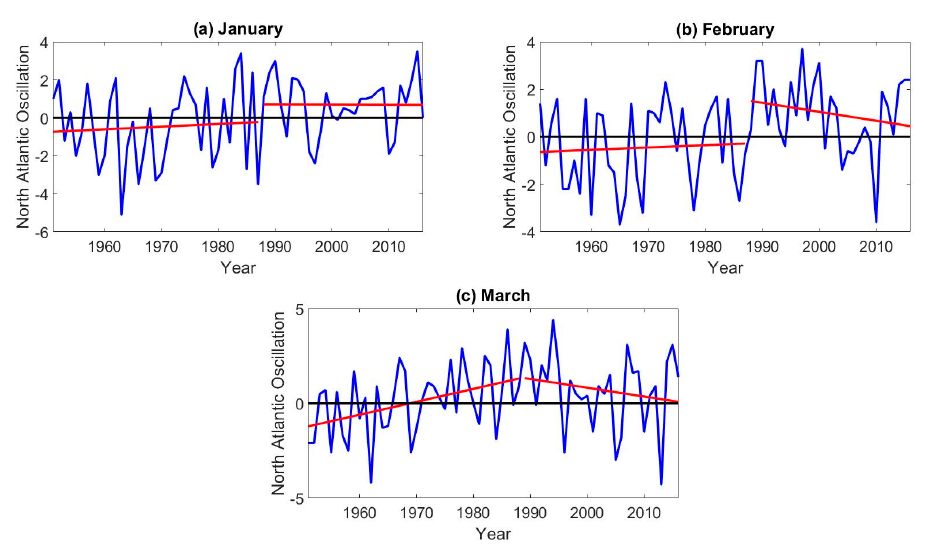
Figure 6. The North Atlantic Oscillation (NAO) trends in ( a ) January, ( b ) February and ( c ) March.